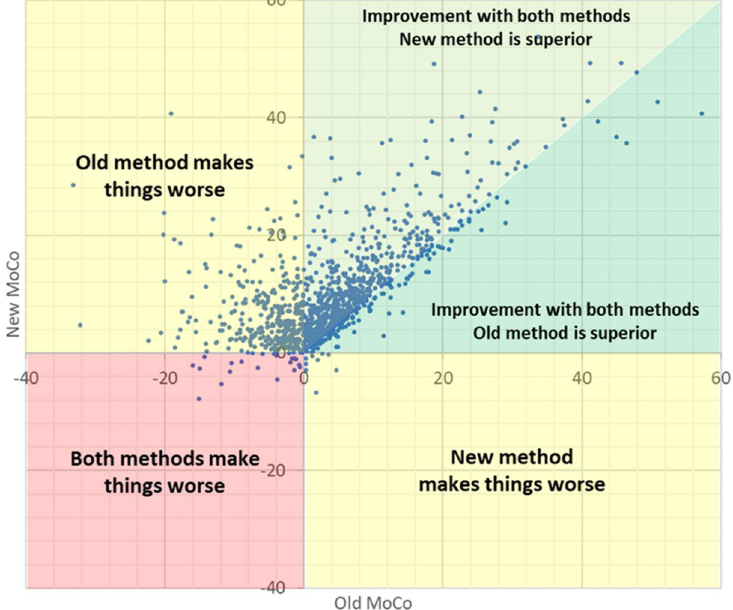
Figure 5. Scatter plot illustrating the relative change in AFP metric obtained with each of the motion correction methods, compared to uncorrected data. Graph created using Excel (Microsoft, Redmond,